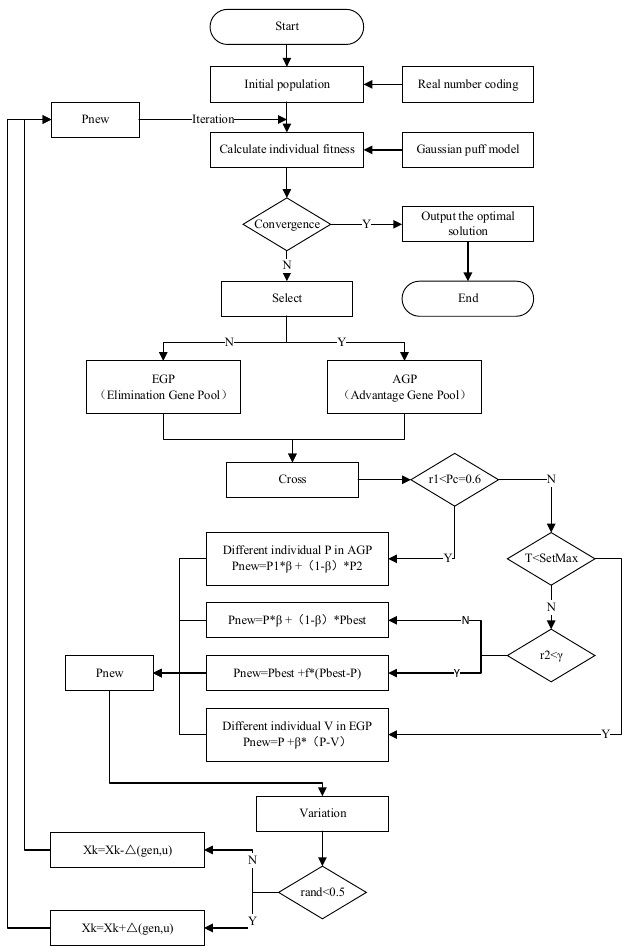
Figure 1. Technical roadmap of improved genetic algorithm.